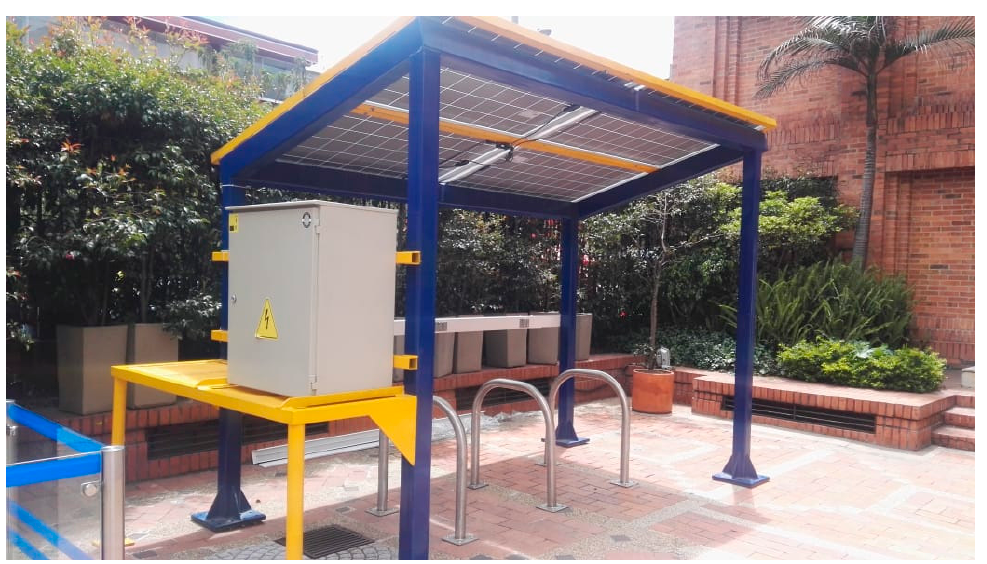
Figure 28. West BiCiSOLAR charging station.